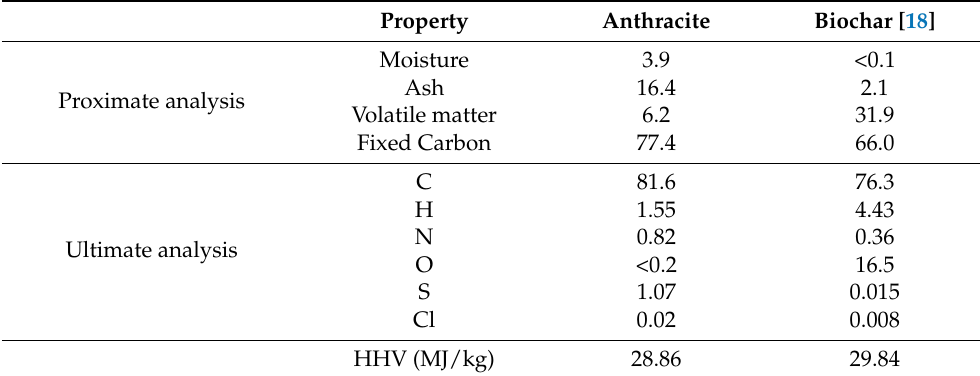
Table 5. Characterization of anthracite and biochar (wt.%